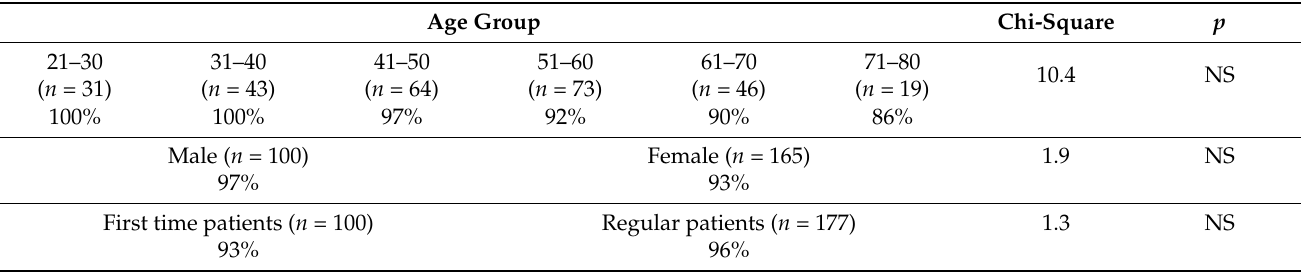
Table 5. Patient’s knowledge about the role of optimal oral hygiene in prevention of periodontitis (Do you think that inadequate oral hygiene affects the presence of periodontal